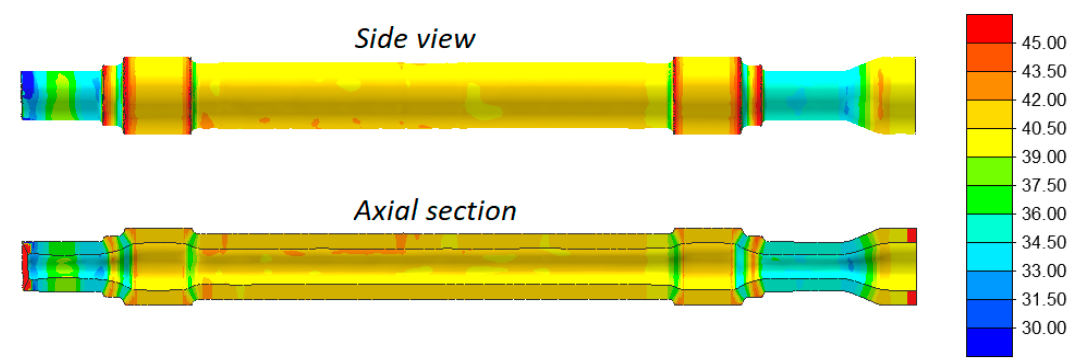
Figure 22. Wall thickness (given in mm) in a 3-roll skew rolled hollow axle after calibration.